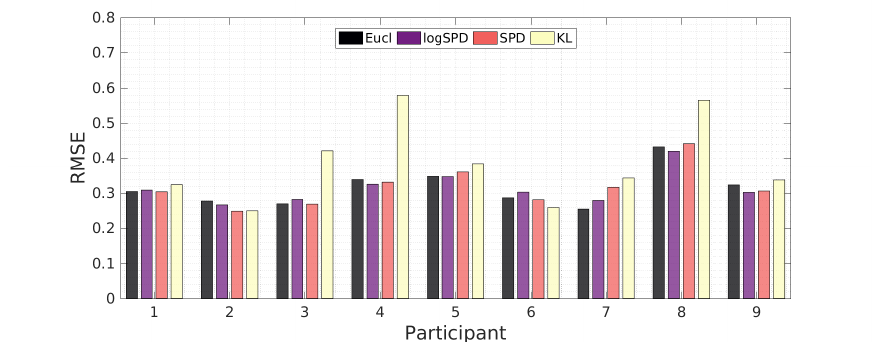
Figure A3. Comparison of the root-mean-square error (RMSE) between Gaussian process regression (GPR) using different kernel distances, with surface electromyography (sEMG) as input, for each participant.